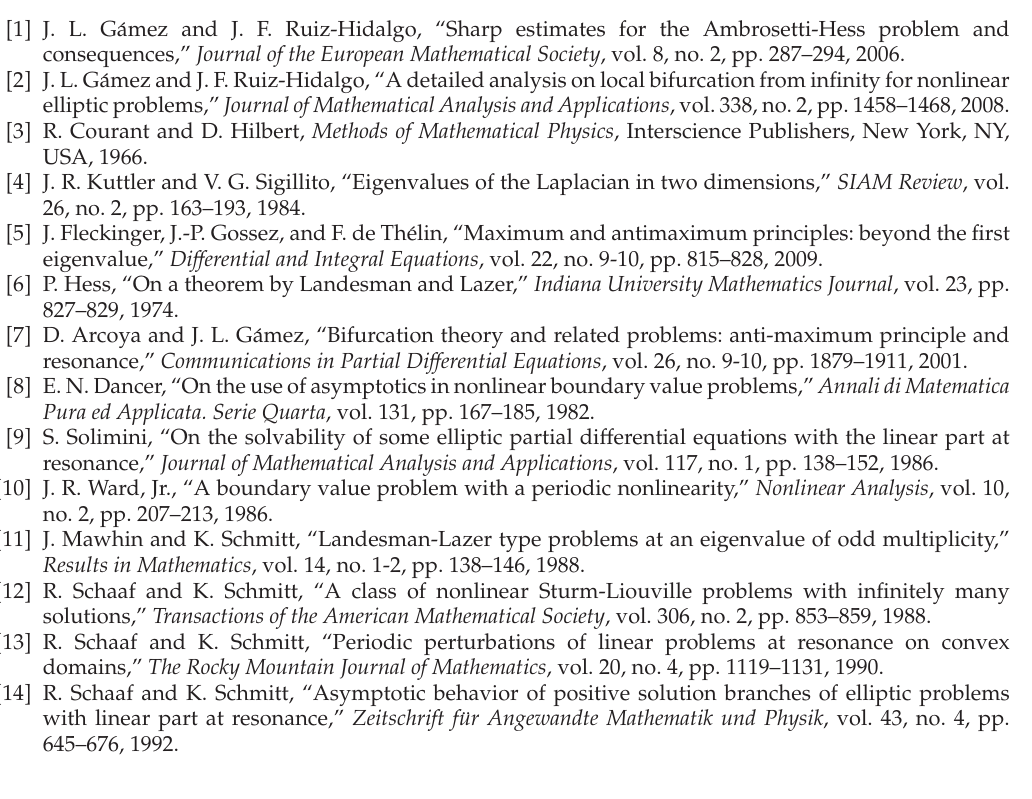
(cid:5) L − for h (cid:3) x (cid:4) (cid:5) sin (cid:3) 7 x (cid:4) k k